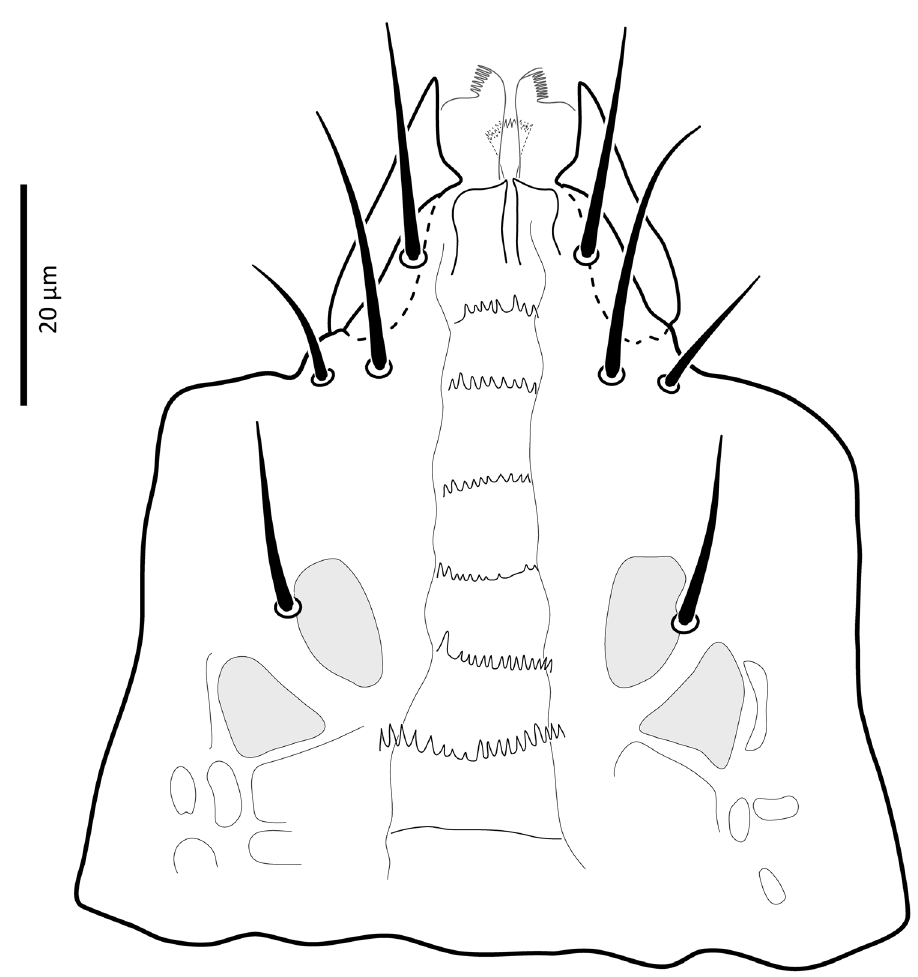
Figure 21. Zygoseius lindquisti sp. n., female,